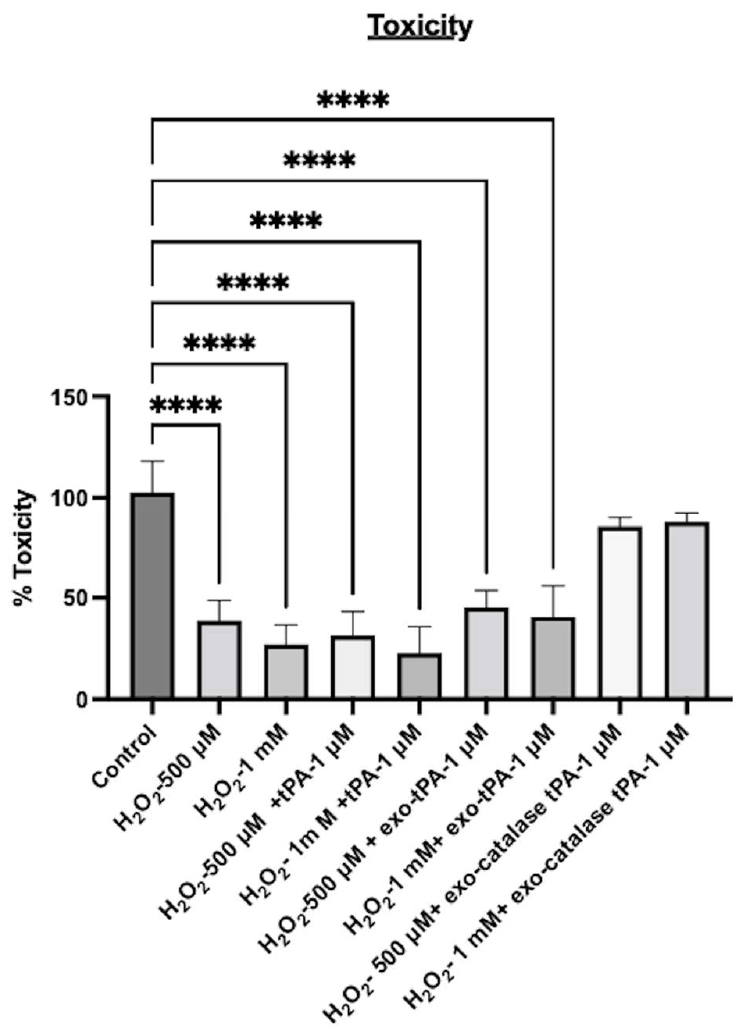
Figure 7. H 2 O 2- induced ROS was assessed with DCFH-DA assay. Cells were treated with tPA or exo-tPA or exo-tPA-catalase with 500 µ M or 1 mM H 2 O 2 . n = 3 ± SEM, **** p <0.0001.